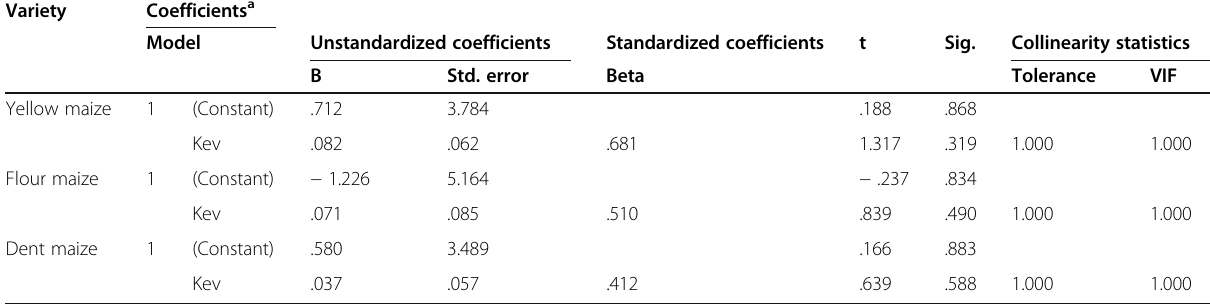
Table 1 Regression coefficients on the yellow maize, flour maize and dent maize varieties for effect of X-ray irradiation on the mortality of S . zeamais after 24 h of exposure Variety